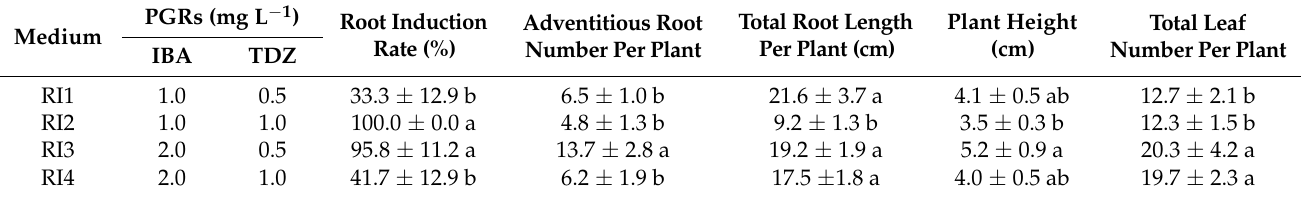
Table 2. Effects of different concentrations of IBA and TDZ on in vitro rooting and plant performance of the matured SEs after 2 months of